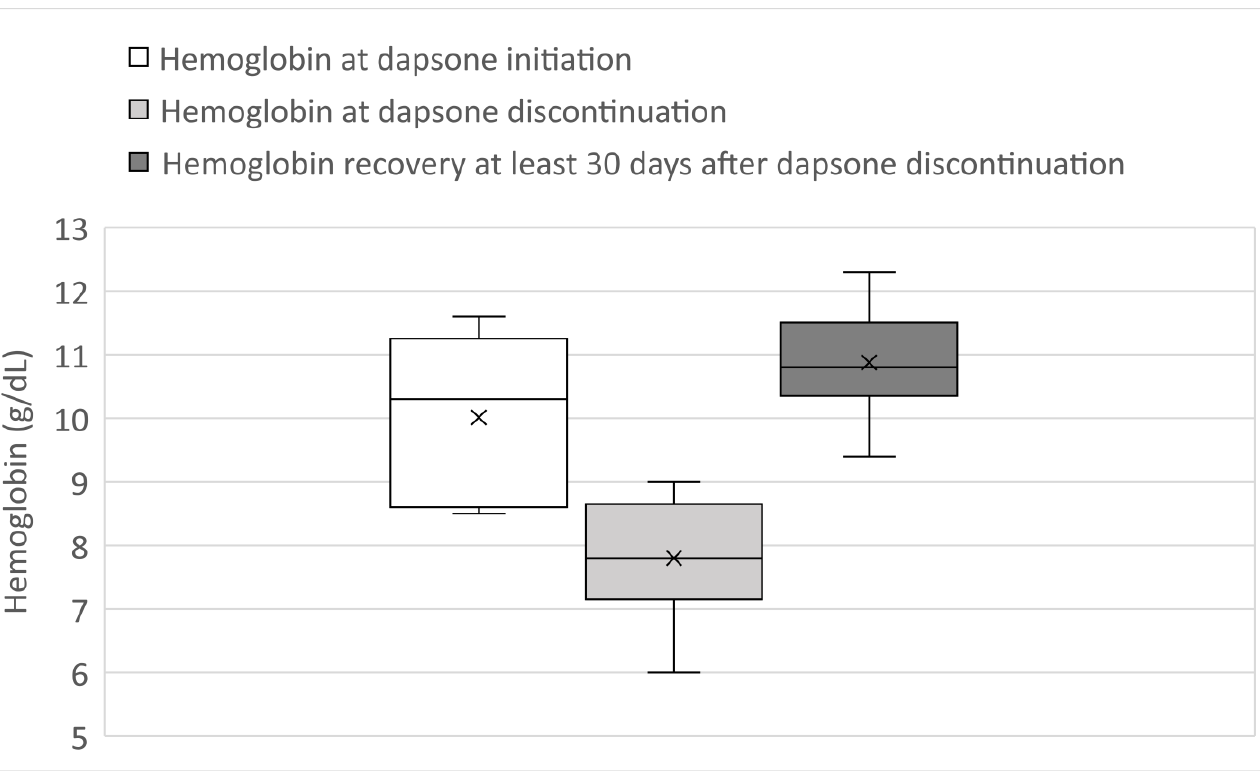
Figure 1. Hemoglobin levels at dapsone initiation, at dapsone discontinuation and at least 30 days after dapsone discontinuation with interquartile ranges, ranges, medians, and means (marked by x). p = 0.0018 comparing hemoglobin at dapsone initiation to hemoglobin at dapsone discontinuation. p < 0.0001 comparing hemoglobin at dapsone discontinuation to hemoglobin recovery. Table 4. The Naranjo probability scale to determine the likelihood of causation of dapsone and anemia. Two patients scored definite causal relationship while six patients scored probable causal relationship. Adapted from Naranjo et al.